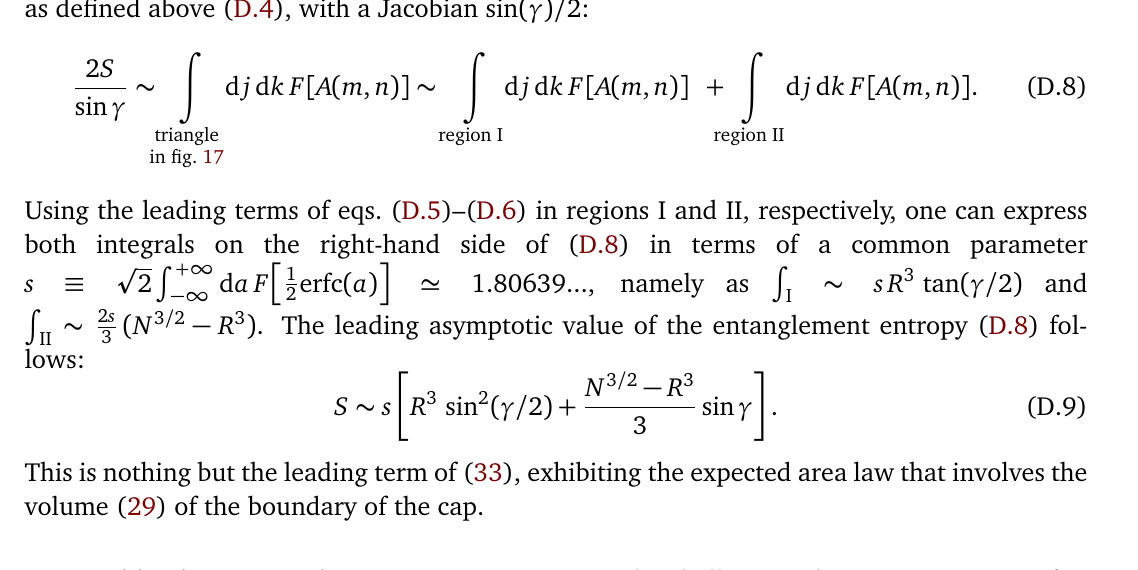
Figure 17: The heat map of fig. 13 in terms of j ≡ m + n and k ≡ n / t − tm , with t ≡ tan ( γ/ 2 ) . The triangle over which one inte- grates in order to evaluate entan- glement entropy is represented in yellow and brown, but, as usual, only the (orange) transition re- gion contributes substantially to the integral (D.8). Owing to the choice of coordinates, this transition region now consists of two segments at nearly constant j (cid:39) R 2 and at nearly constant k (cid:39)